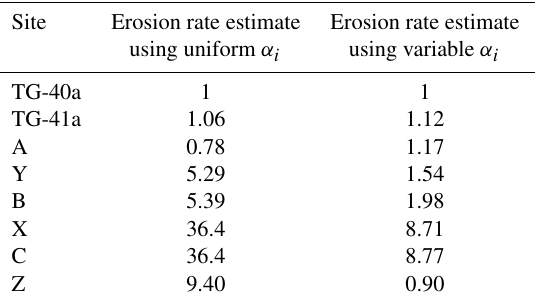
Table 3. Predicted erosion rate in the successive sub-catchments obtained by assuming uniform values for the α i and variable values derived from the relative abundance of muscovite-bearing surface rock in the geological map.